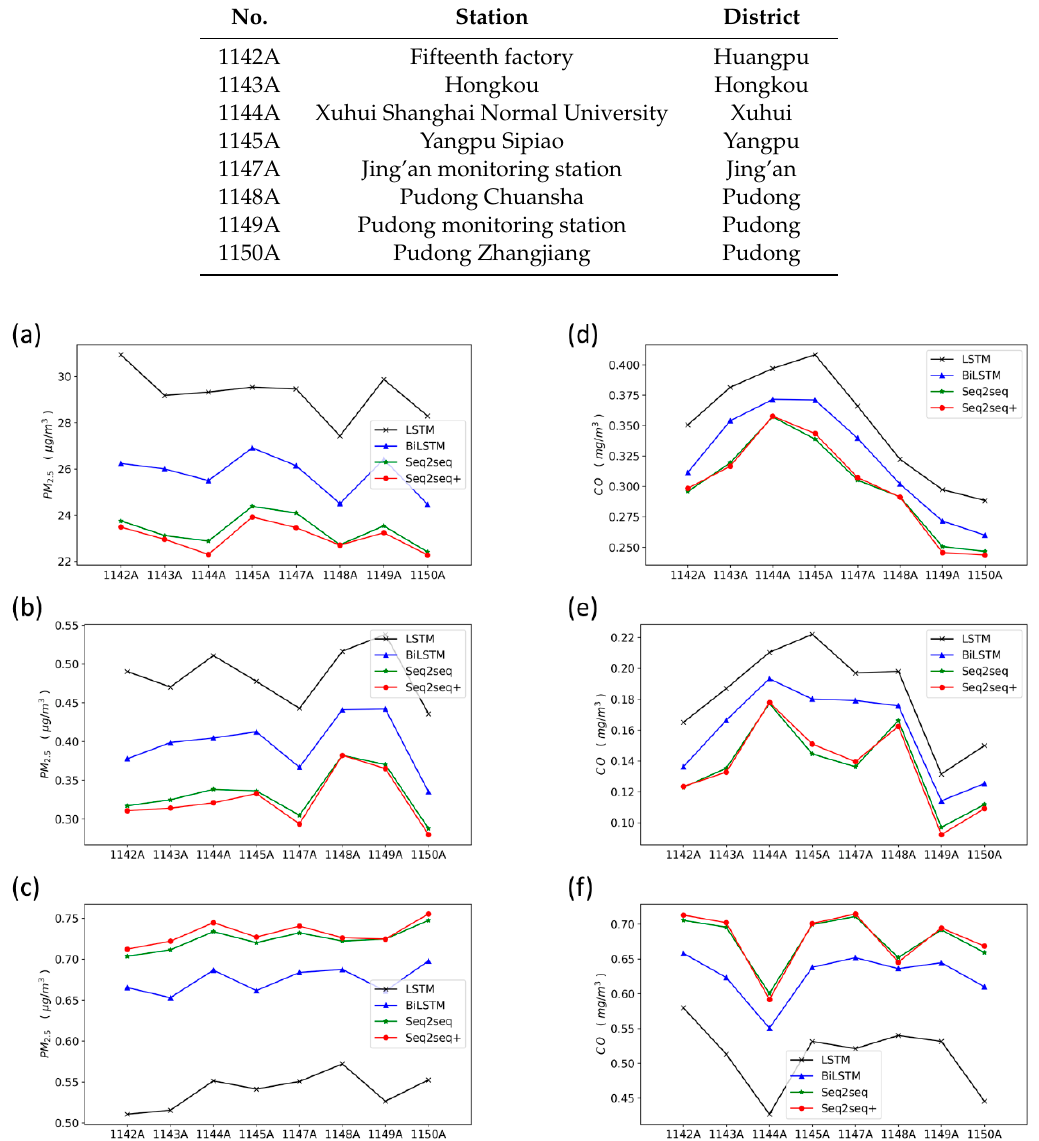
Figure 10. Comparison of the forecasting model results for 8 urban air quality monitoring stations. ( a